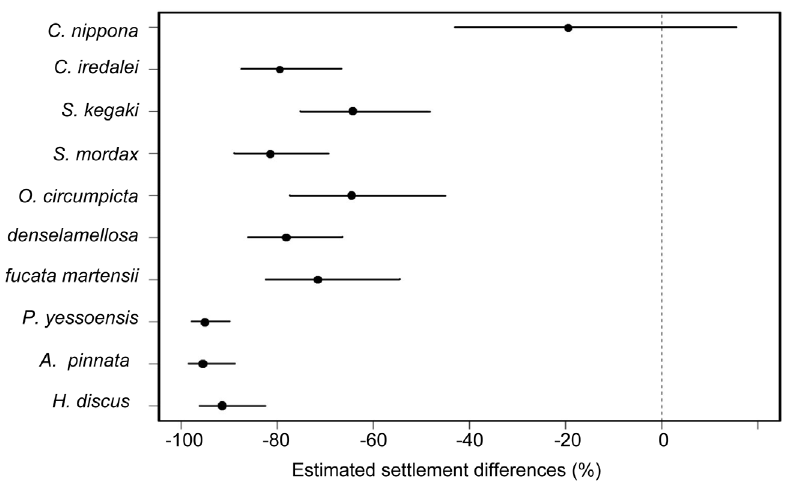
Figure 3. Estimated percent settlement differences of the 10 molluscan species SC vs.C.gigas SC (0). Closed circles represent mean estimates and error bars are 95% confidence intervals. Estimated settlement differences between the ten molluscan species and C. gigas (as the reference) were calculated based on the odds ratios.